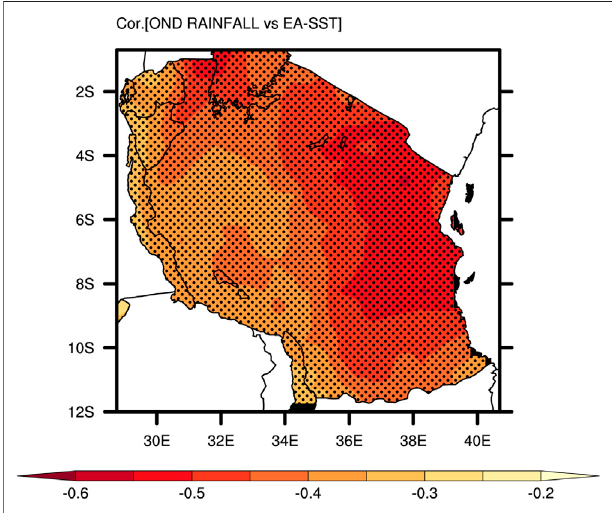
FIGURE 6 | Correlation map of OND rainfall in Tanzania with OND EA- SST index during 1950 – 2017. Regions above the 99% con fi dence level are